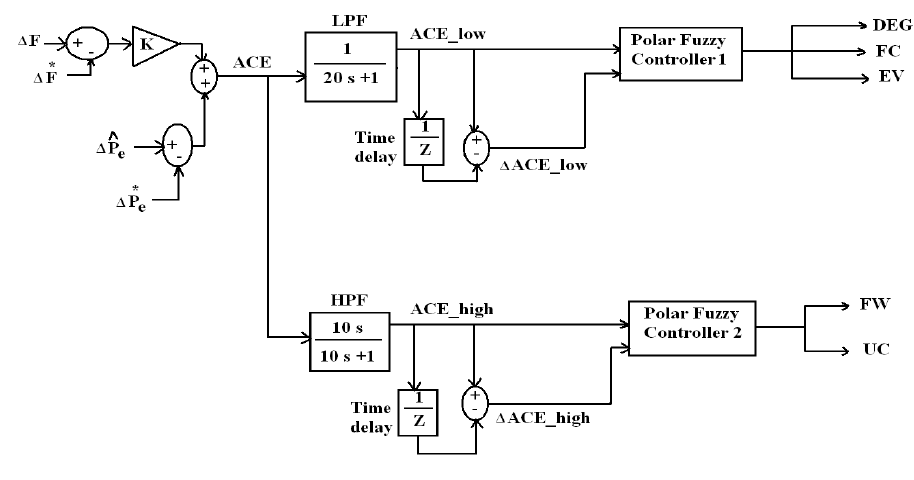
Figure 5. Polar fuzzy (PF) controllers’ scheme.